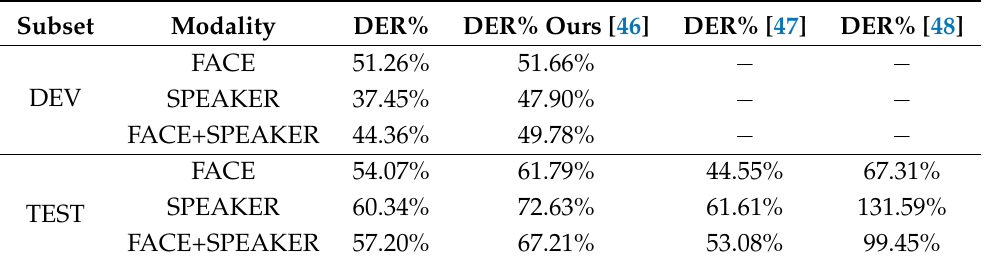
Table 4. Experimental results on RTVE 2020 Multimodal Diarization development and test sets, showing DER%. These DER% values were the result of the improvements introduced in this work, and the reference results for both modalities are also